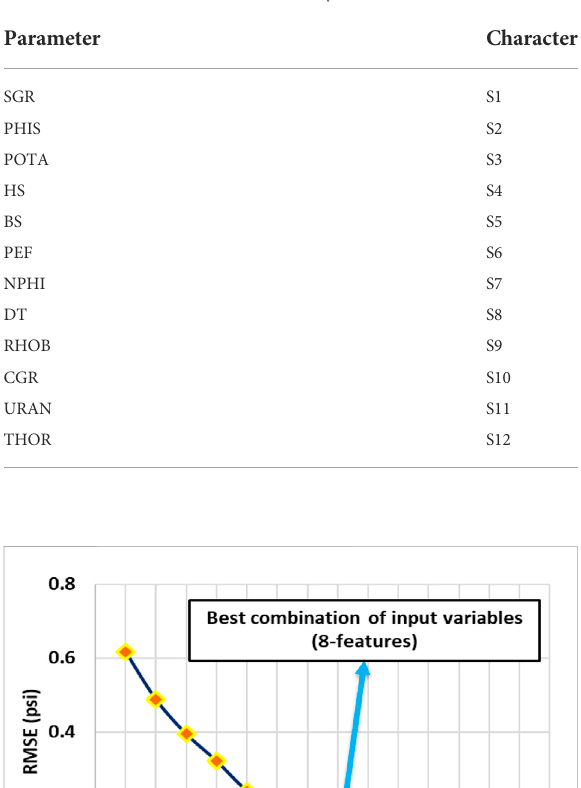
TABLE 3 Feature selection ’ s lable for input variables.